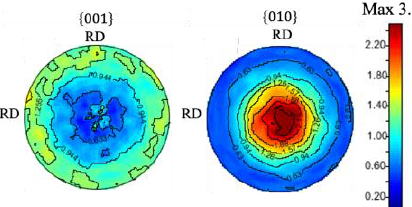
Figure 8 . Pole figures of the compressed sample obtained by the neutron diffraction experiments.